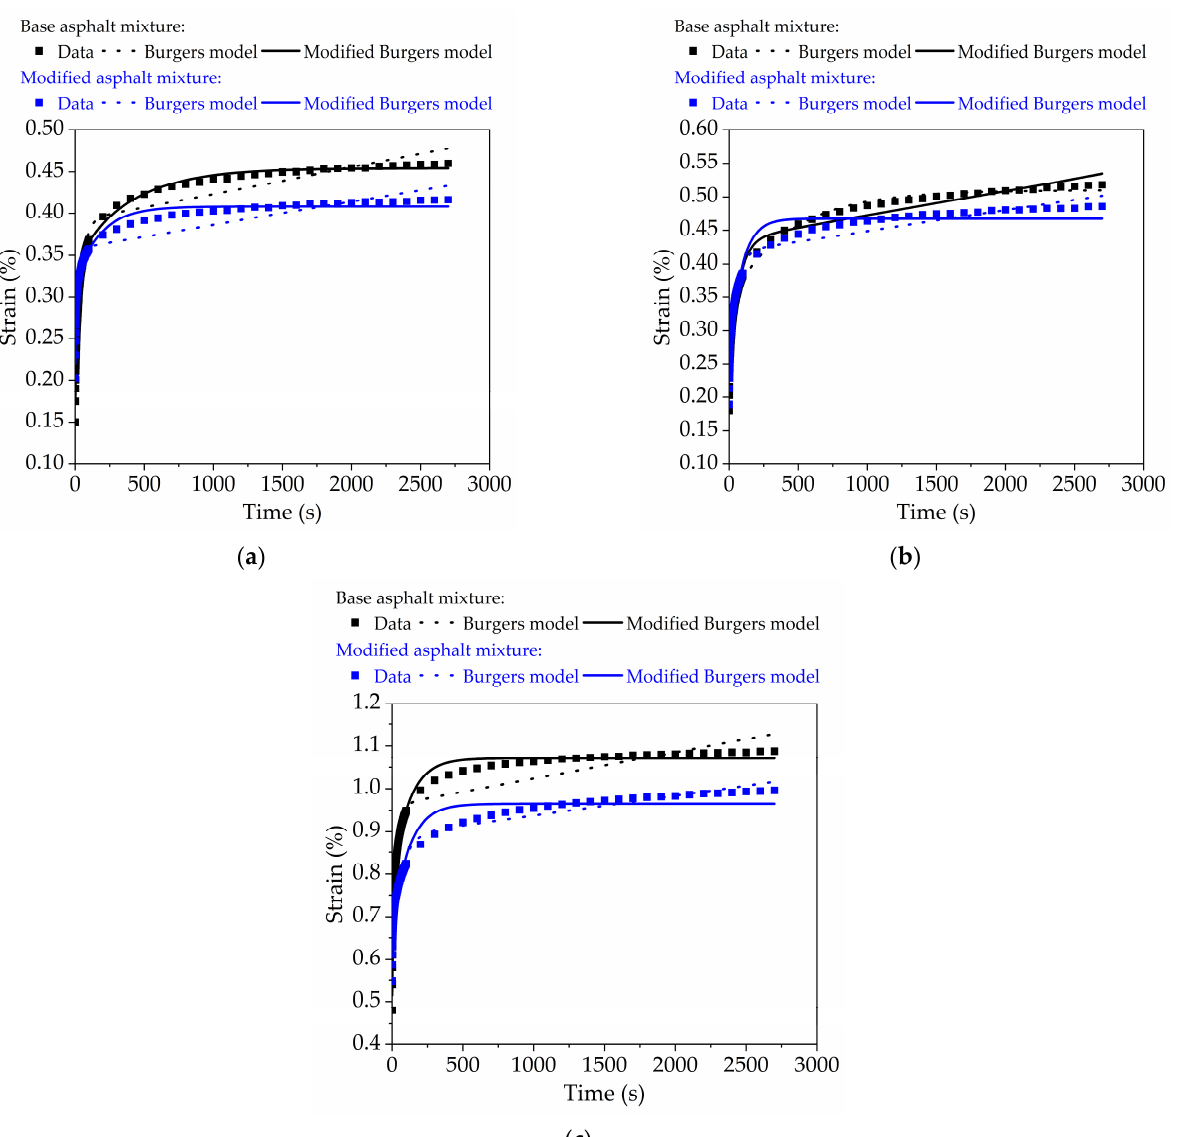
Figure 10. Comparative results of Burgers model and modified Burgers model for bituminous mixtures versus time: ( a ) 20 °C; ( b ) 35 °C; and ( c ) 50 °C.